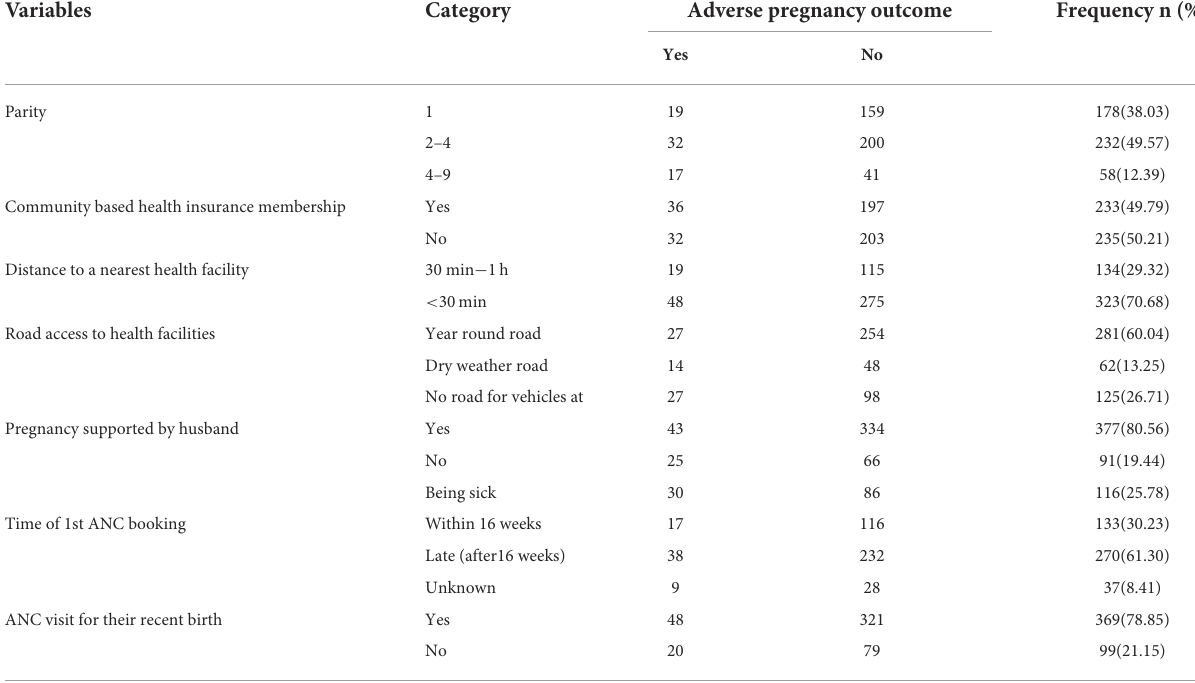
TABLE 2 Obstetrics related characteristics of study participants in Northwest, Ethiopia, 2021 ( n = 468). Variables